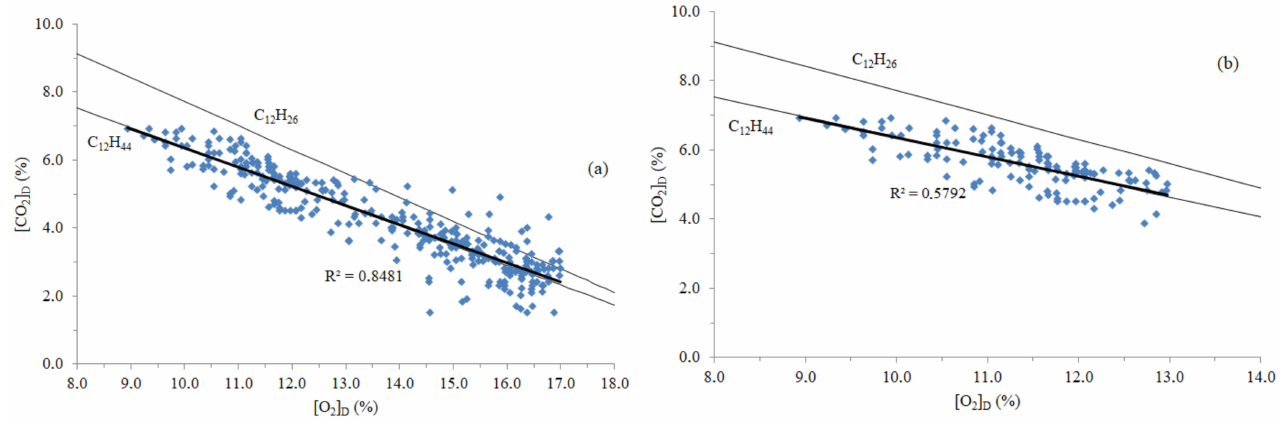
Figure 7. The CO 2 concentration as a function of O 2 concentration, both on a dry basis, for the combustion of diesel fuel in Truck #4: for [O 2 ] D < 17% ( a ), for [O 2 ] D < 13% ( b ).